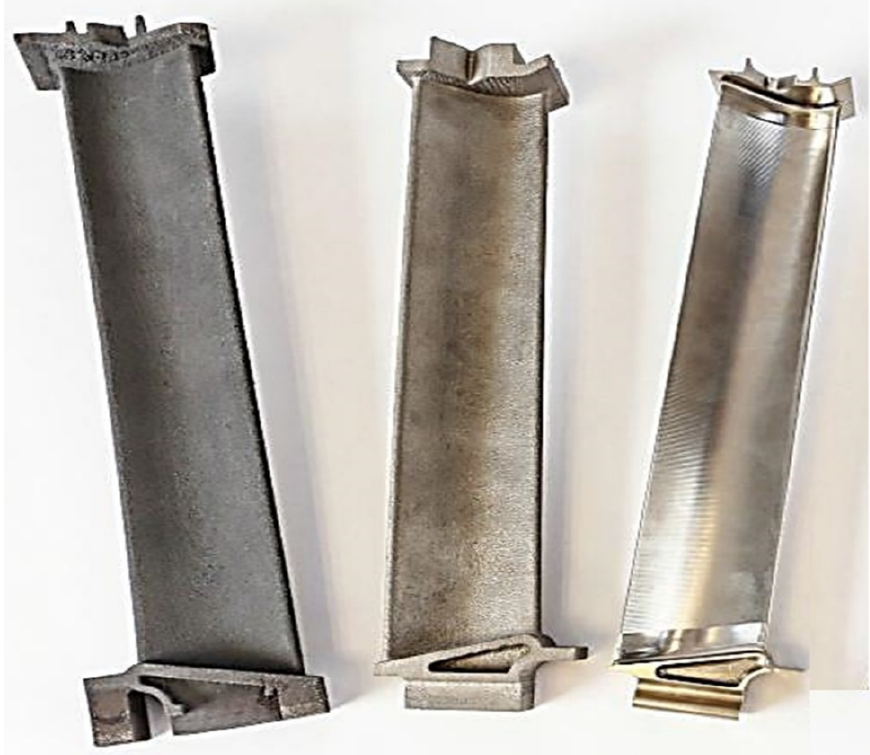
Figure 10. The 3D-printed TiAl blades for LPT of the GE90X engine [89].